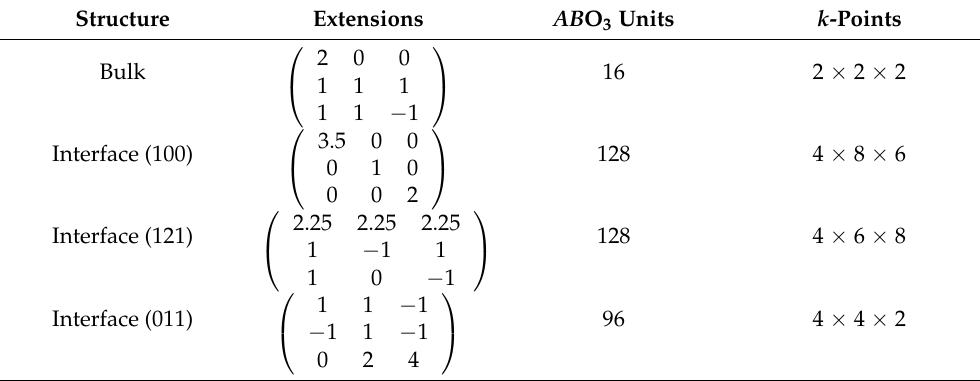
Table 2. Interface cells parameters—extensions in units of the original lattice vectors ( Pnma setting) and k -points, relative to the new basis.